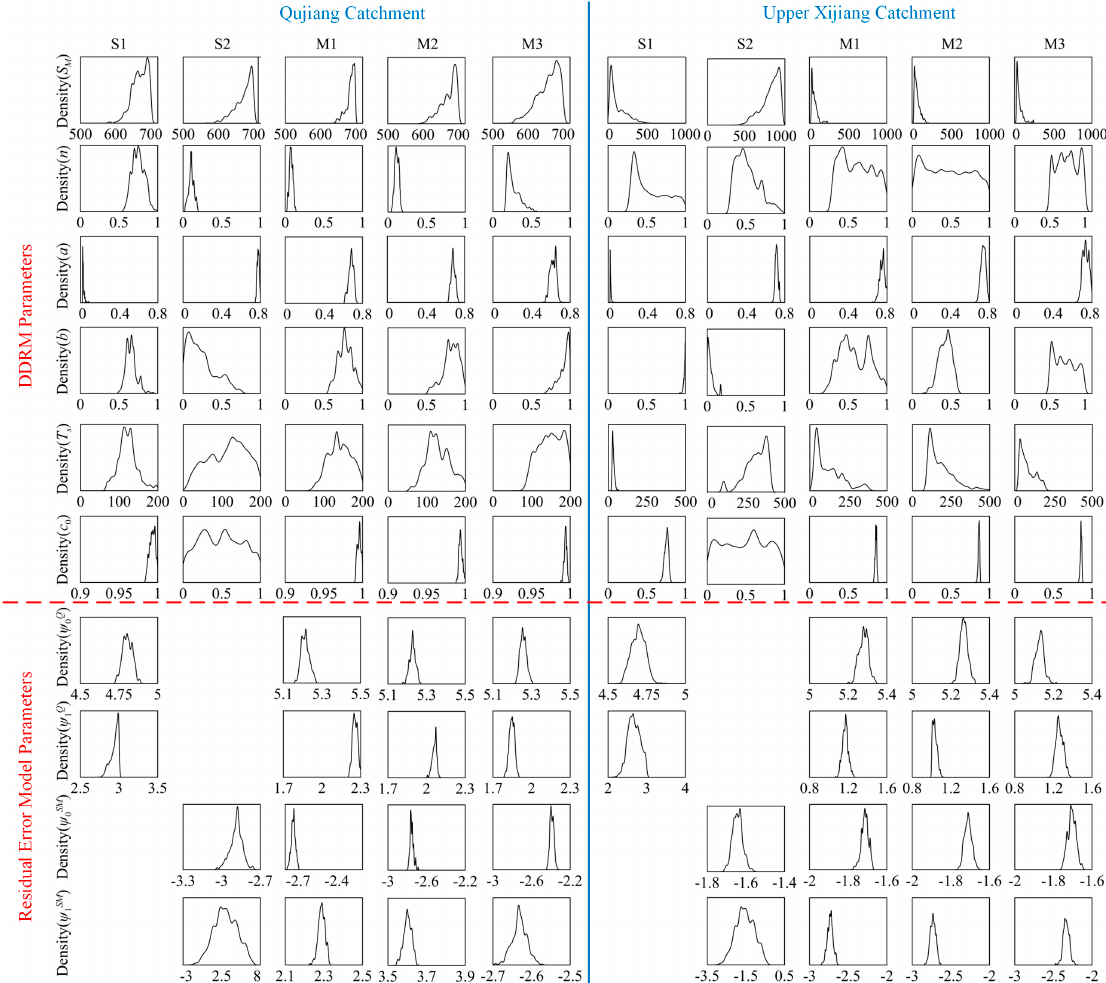
Figure 7. Posterior distributions for hydrological model parameters with high sensitivity to soil moisture or streamflow (first six rows) and residual error model parameters (the last four rows) for multiple calibration scenarios (single objective S1–S2, multi-objective M1–M3) in Qujiang and Upper Xijiang catchments.